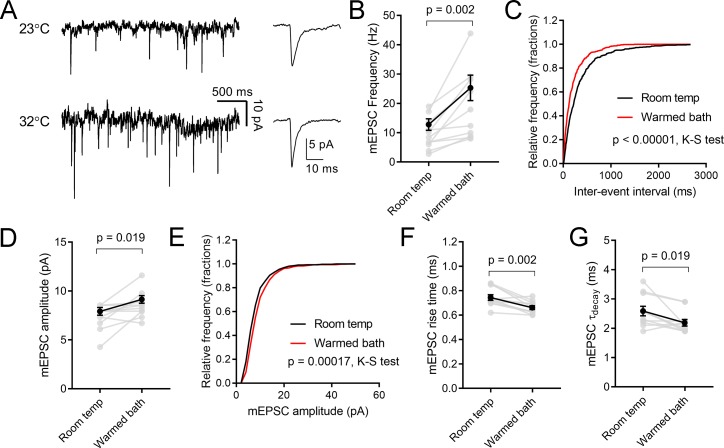
Temperature alters mEPSCs recorded in dLGN TC neurons.A) Voltage-clamp traces of mEPSCs recorded in the absence of stimulation at room temperature and then following warming of the bath solution. Traces on the right show the average mEPSC waveforms detected in each temperature condition from that cell. B) Median mEPSC frequency from 11 TC neurons increased with warming. C) Cumulative distribution of mEPSC inter-event intervals (100 events per temperature condition per recorded cell) show that the intervals shifted left indicating that frequency increased. D) Plots of median mEPSC amplitude from 11 TC neurons show that mEPSC amplitude increased with warming. E) Cumulative distribution of mEPSC amplitudes. F & G) Warming accelerated the mEPSC rise time and decay time constant.